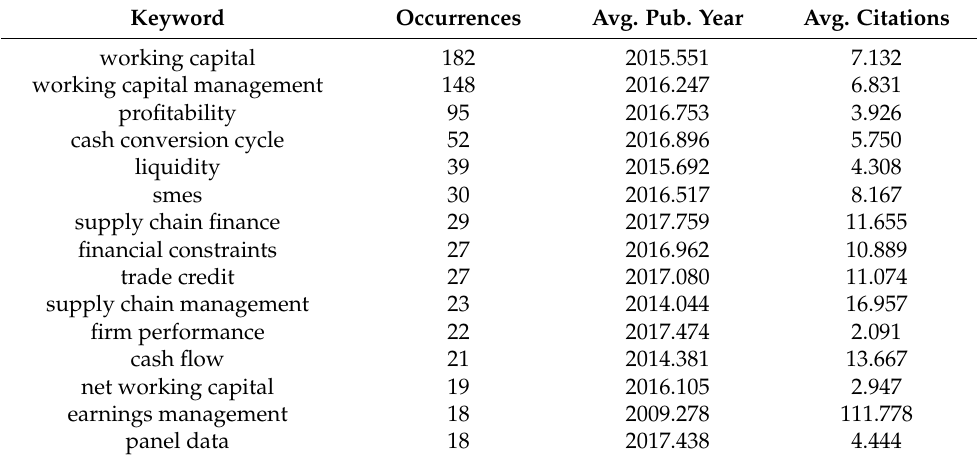
Table 2. Co-occurrence links and top 15 (occurrences) author keywords, considering 1 as the mini- mum number of occurrences of a keyword and 1000 as the number of keywords